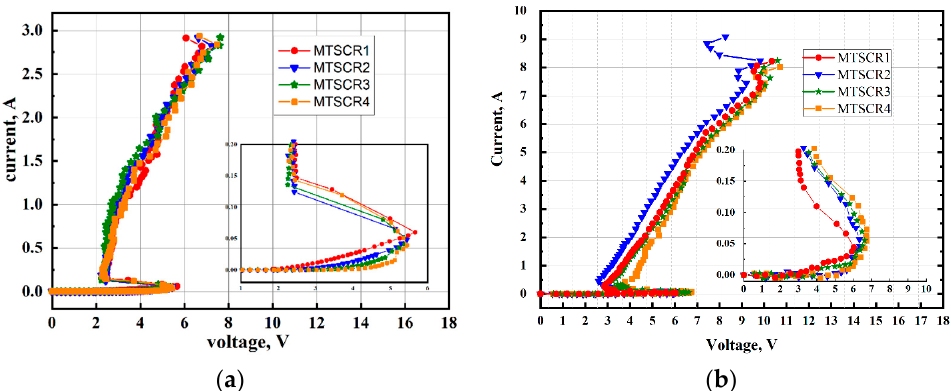
Figure 3. ( a ) TLP and ( b ) VF-TLP test results of MTSCRs with N = 3, 4, 5, and 6. The rise time of the TLP and VFTLP pulse are 10 ns and 200 ps, respectively. Table 1. TLP and VF-TLP test results of MTSCRs.